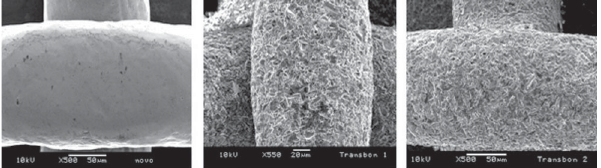
Fig. 3 - Scanning electron micrographs of a bracket base (A) after first (B) and second recycling (C) with aluminum oxide blasting.